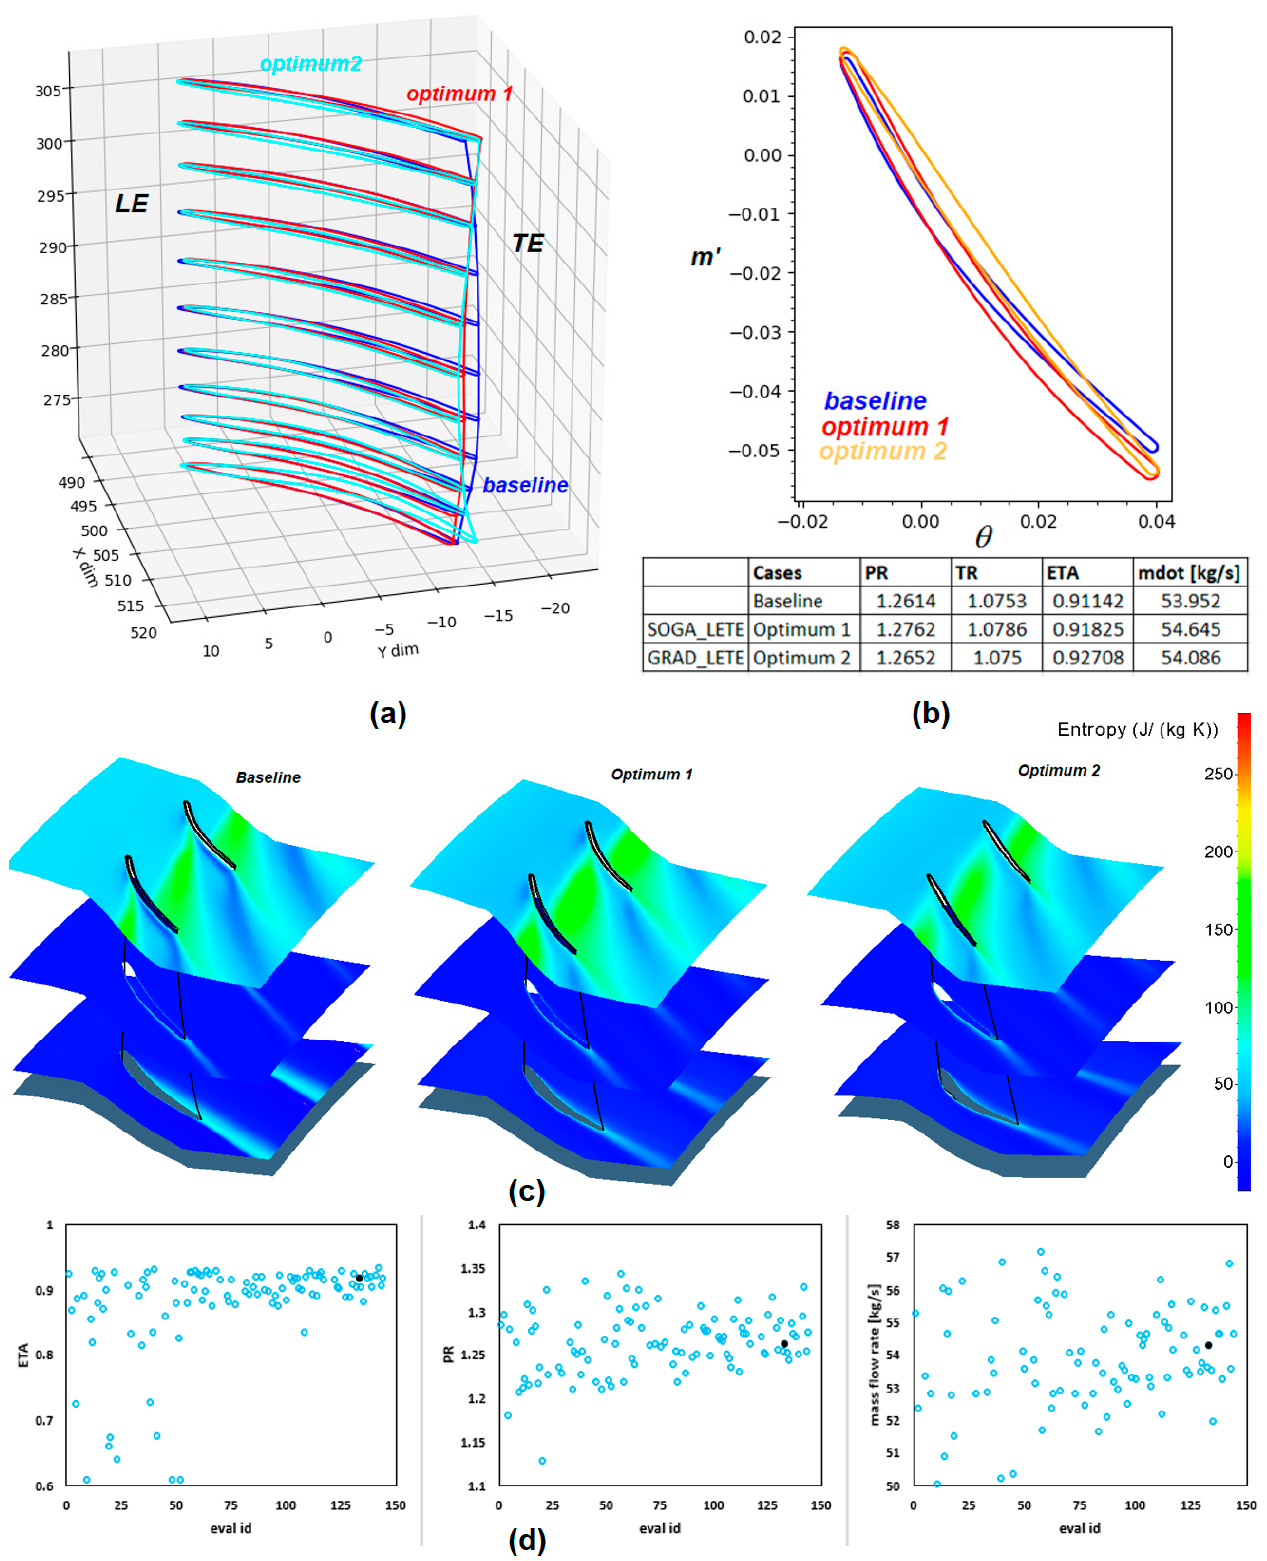
Figure 17. 3D blades for baseline, optimum 1, and optimum 2 along with 1D performance metrics and tip airfoils are compared in (a) and (b). Entropy contours at hub, mid, and near the tip are also shown in (c). Evolution of objective function and constraints with each evaluation is plotted with optimum values as black dots in (d).